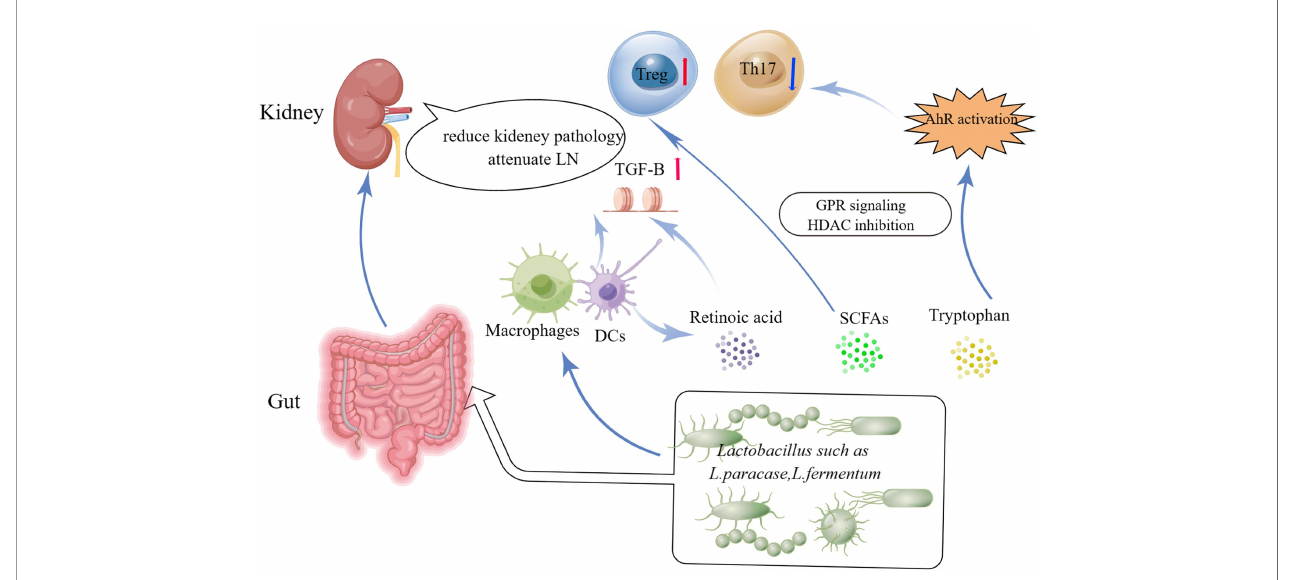
FIGURE 1 | Potential bene fi cial functions of Lactobacillus and Lactobacillus -derived bioactive metabolites in the treatment of SLE and the communication pathways on Lactobacilli -kidney axis. HDACs, histone deacetylases; GPCRs, ligands for G-protein-coupled receptors; SCFAs, Short-chain fatty